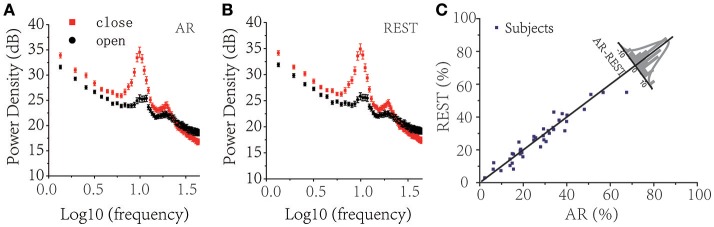
Resting EEG Power spectrum analysis between eyes-closed (red square solid points) and eyes-open (black round solid dots) under different reference choices. (A) AR, (B) REST. (C) Difference of alpha-blocking rate (characterized as ΔPα¯ under alpha band, 8–12 Hz, Pclose is the summation of logarithm of eyes-closed power spectrum and Popen is the summation of the logarithm of the eyes-open power spectrum) of 38 subjects (average all electrodes) at different reference electrodes (AR & REST), in which 19 of 38 subjects showed that REST performed better than AR.